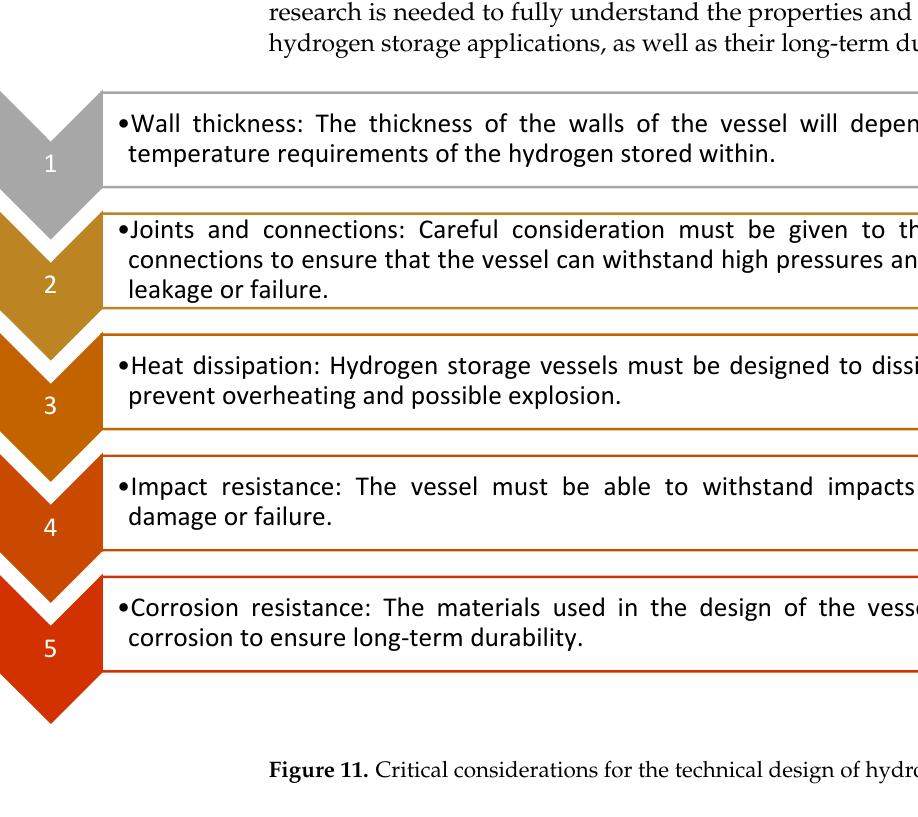
Figure 11. Critical considerations for the technical design of hydrogen storage.